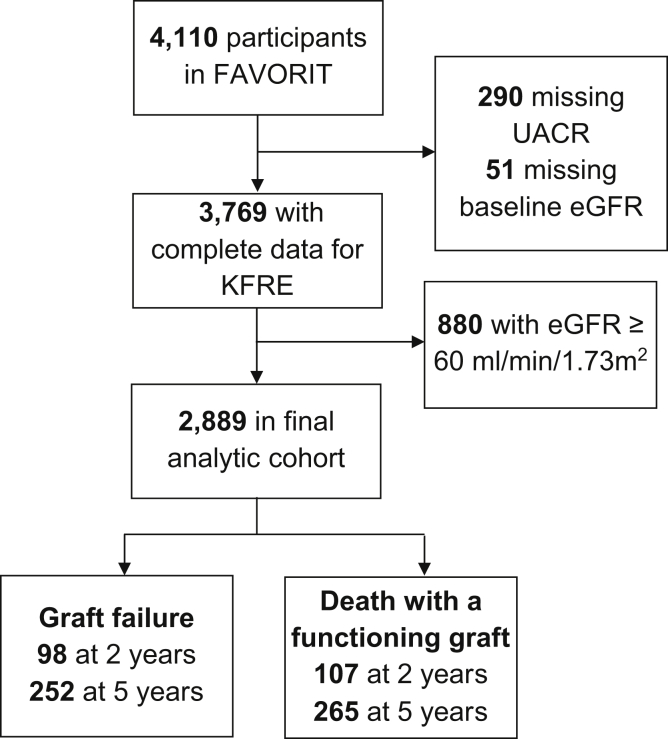
Study flow diagram. Abbreviations: eGFR, estimated glomerular filtration rate; FAVORIT, Folic Acid for Vascular Outcomes Reduction in Transplantation Trial; KFRE, Kidney Failure Risk Equation; UACR, urinary albumin-creatinine ratio.